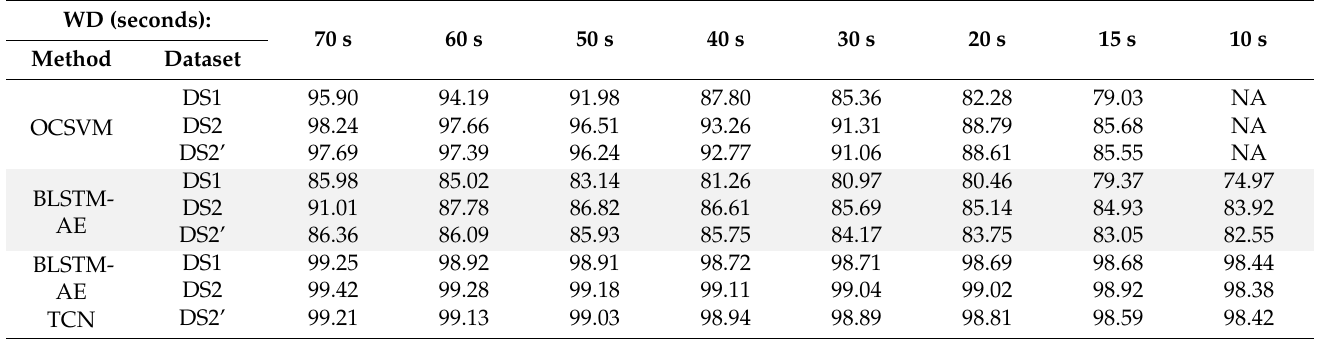
Table 6. Average ACC percentages of the three approaches for the varying window durations.